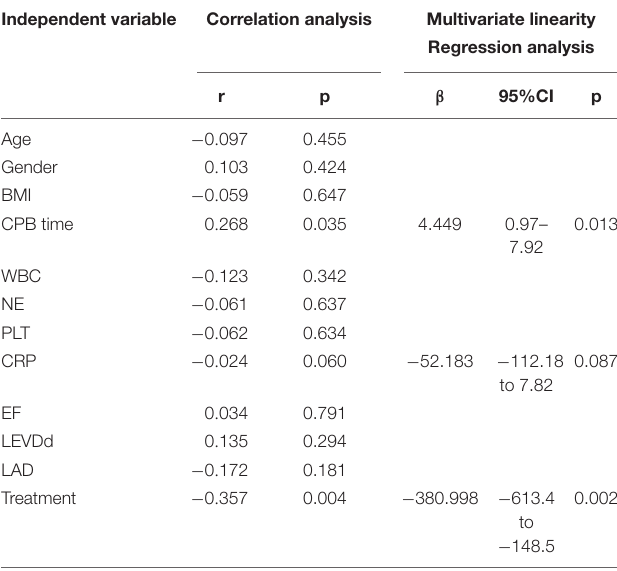
TABLE 6 | Correlation and multivariate regression analysis of potential risk factors for cTnI 12 h after surgery. Independent variable Correlation analysis Multivariate